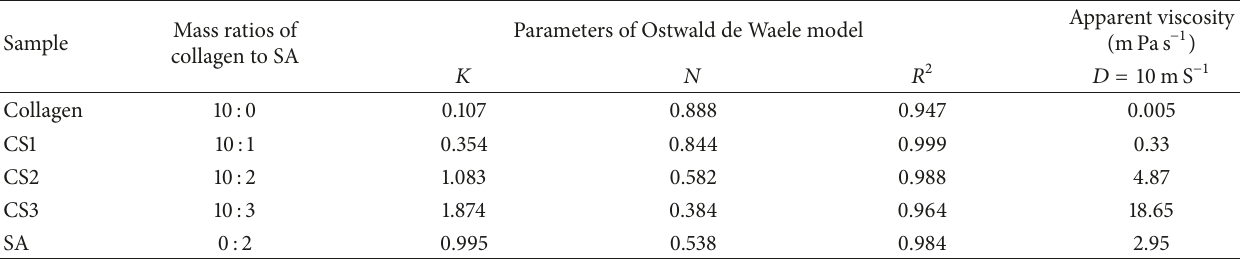
Table 1: Rheological properties of film-forming solutions: index of consistency ( 𝐾 ) and flow-behavior ( 𝑛 ) calculated by the Ostwald de Waele model. Apparent viscosity values at 10mS −1 shear rate ( 𝐷 ).